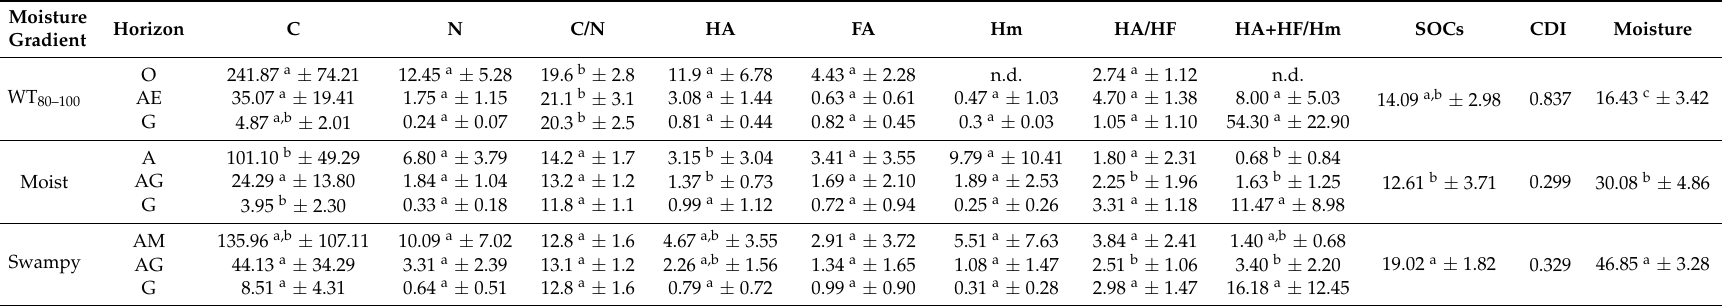
Table 4. Humus substances, organic carbon and nitrogen content, moisture of study